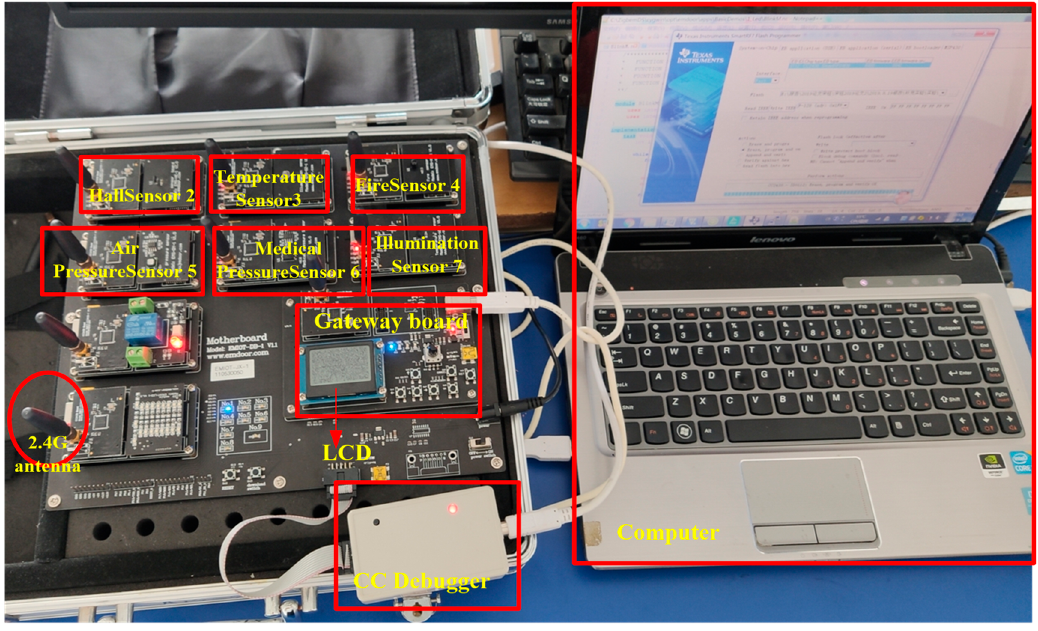
Figure 4. Building an experimental platform.